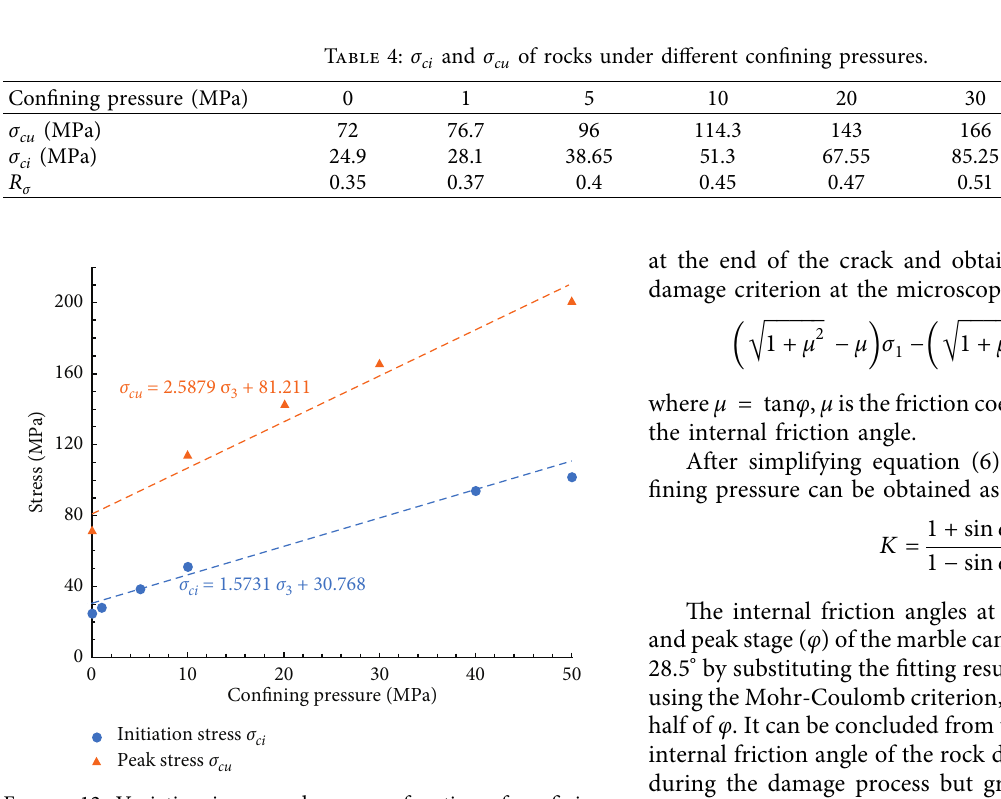
ci and σ cu as a function of confining